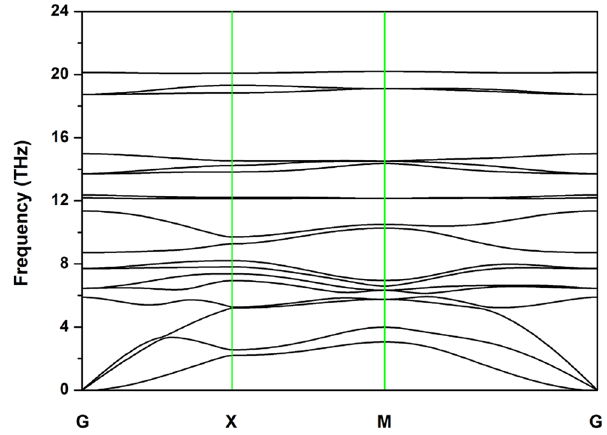
Figure 2. Calculated phonon dispersion of penta-BP 5 monolayer.